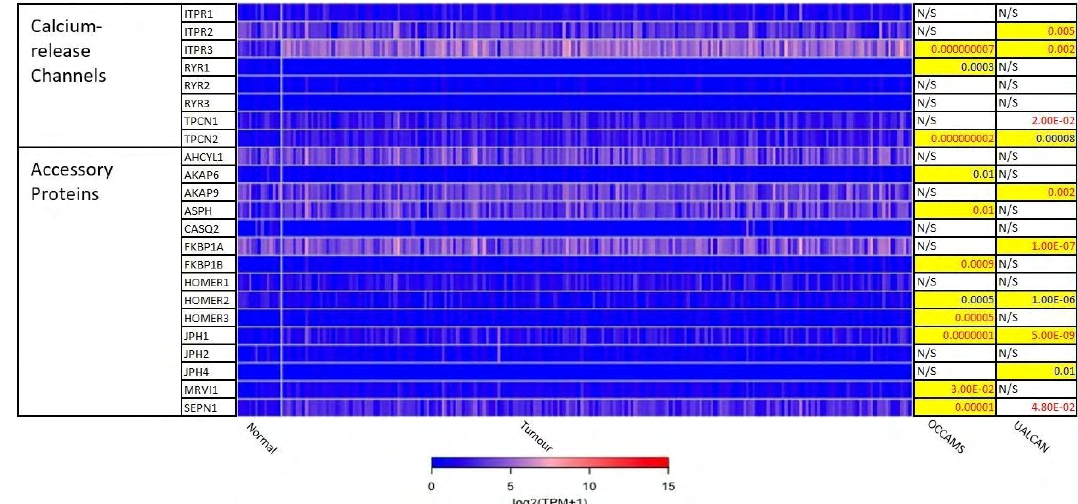
Figure 5. Expression of Ca 2+ -release channels and their accessory proteins in OAC. JPH3 was not available from the OCCAMS data and was neither significantly upregulated nor downregulated in UALCAN. For details, please see Figure 2 . ITPR: IP3 receptor gene; AHCYL: adenosylhomocysteinase-like; ASPH: aspartate β-hydroxylase; CASQ: calsequestrin; FKBP: FK506-binding protein; MRVI1: murine retrovirus-integration site 1 homolog; SEPN1: selenoprotein N1